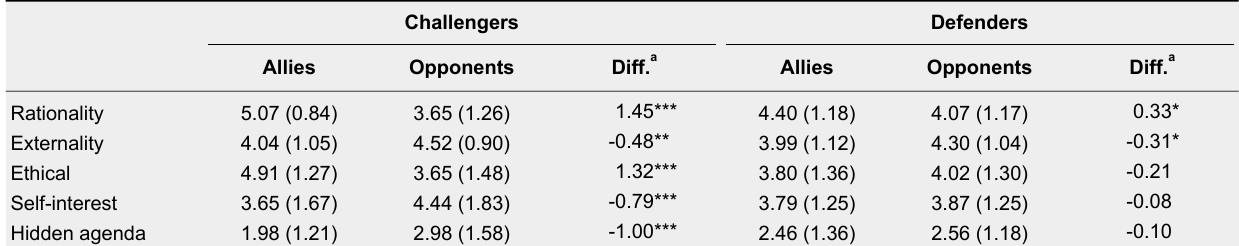
Means and Standard Deviations of Ratings for Challengers and Defenders of the Status Quo (Study 3, N = 109)